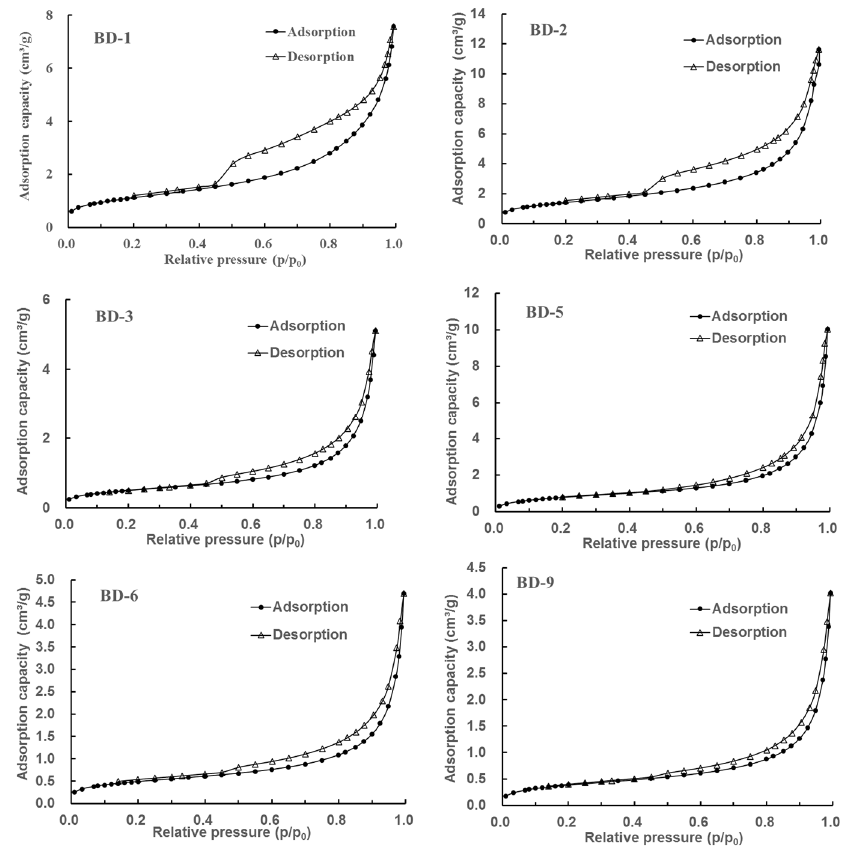
Figure 8. Typical nitrogen adsorption and desorption curve of coal samples in Baode block.